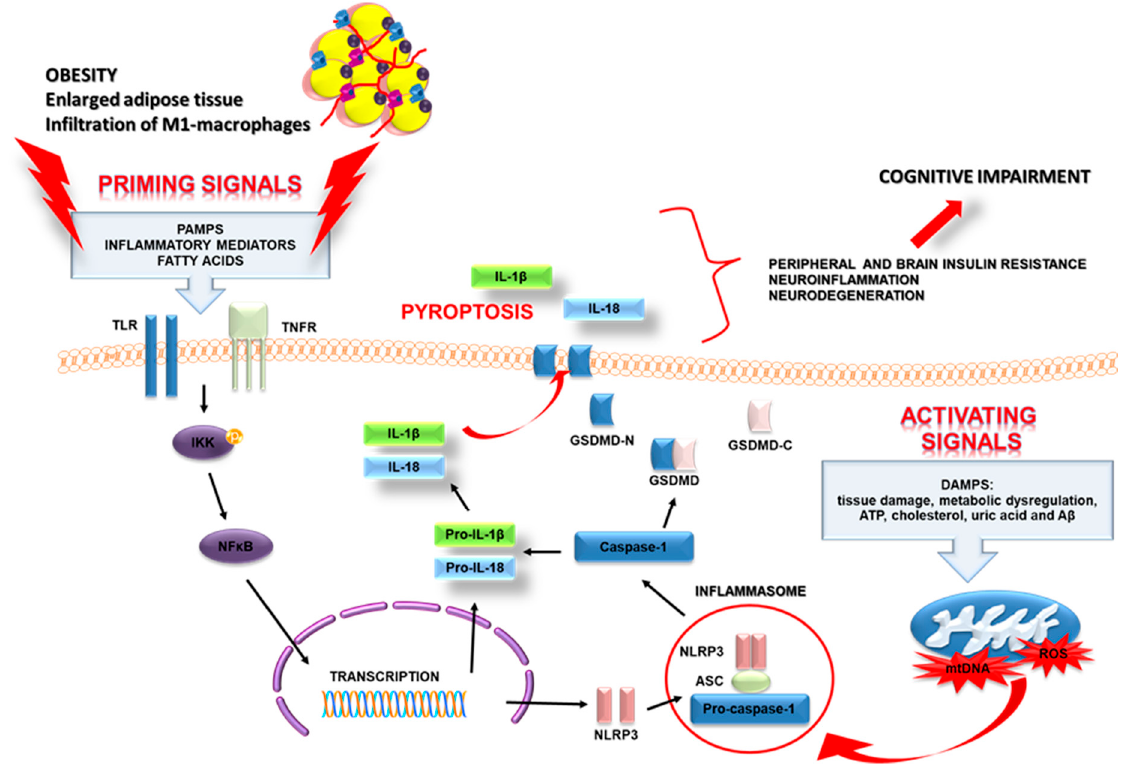
Figure 3. Scheme of the NLRP3 inflammasome activation in metabolic diseases. The activation of NLRP3 requires two distinct, independent signals. The first signal has been referred to as a “priming signal”, while the second is referred to as an “activating signal”. The priming signal is started when PAMPs and/or other inflammatory mediators (IL-1 β and TNF- α ) bind to their respective receptors (PRRs, IL-1 β R, and TNF α R). Binding to the receptors induces the activation and translocation into the nucleus of nuclear factor kappa-light-chain-enhancer of activated β cells (NF- κβ ), which in turn, promotes the transcription of NLRP3, pro-IL-1 β , and pro-interleukin-18 (pro-IL-18). The second signal activation of the NLRP3 complex involves several extracellular stimuli, DAMPS, such as tissue damage, metabolic dysregulation, ATP, cholesterol, uric acid, and amyloid β . It results in mitochondrial dysfunction and the release of ROS (reactive oxygen species) and mitochondrial DNA (mtDNA). ROS and oxidized mtDNA trigger NLRP3 inflammasome formation and activation, which allow caspase-1 to start the cleavage of pro-IL-1 β and pro-IL-18. The active caspase-1 also cleaves the inactive pro-form of gasdermin D (GSDMD) into two fragments: the N-terminal domain and the C-terminal domain. The GSDMD N-terminal fragments are needed for pore formation on the cell membranes. These pores are necessary for the release of inflammatory factors (IL-1 β , IL-18) and for cell swelling, and membrane rupture. They eventually trigger a lytic, pro-inflammatory form of cell death, termed pyroptosis. Moreover, the release of IL-1 β and IL-18 may amplify innate immune response not only locally in adipose tissue but also in the whole organism, making it systemic. Consequently, it contributes to inflammaging, which likely represents the initial stage of cognitive impairment and neurodegeneration.